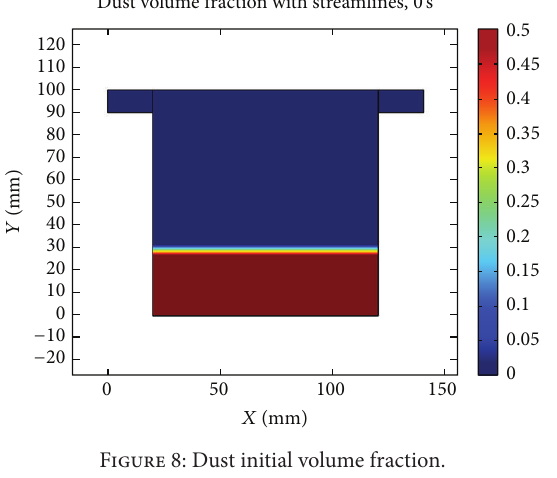
Figure 10: Dust volume fraction with streamlines after 1 s.